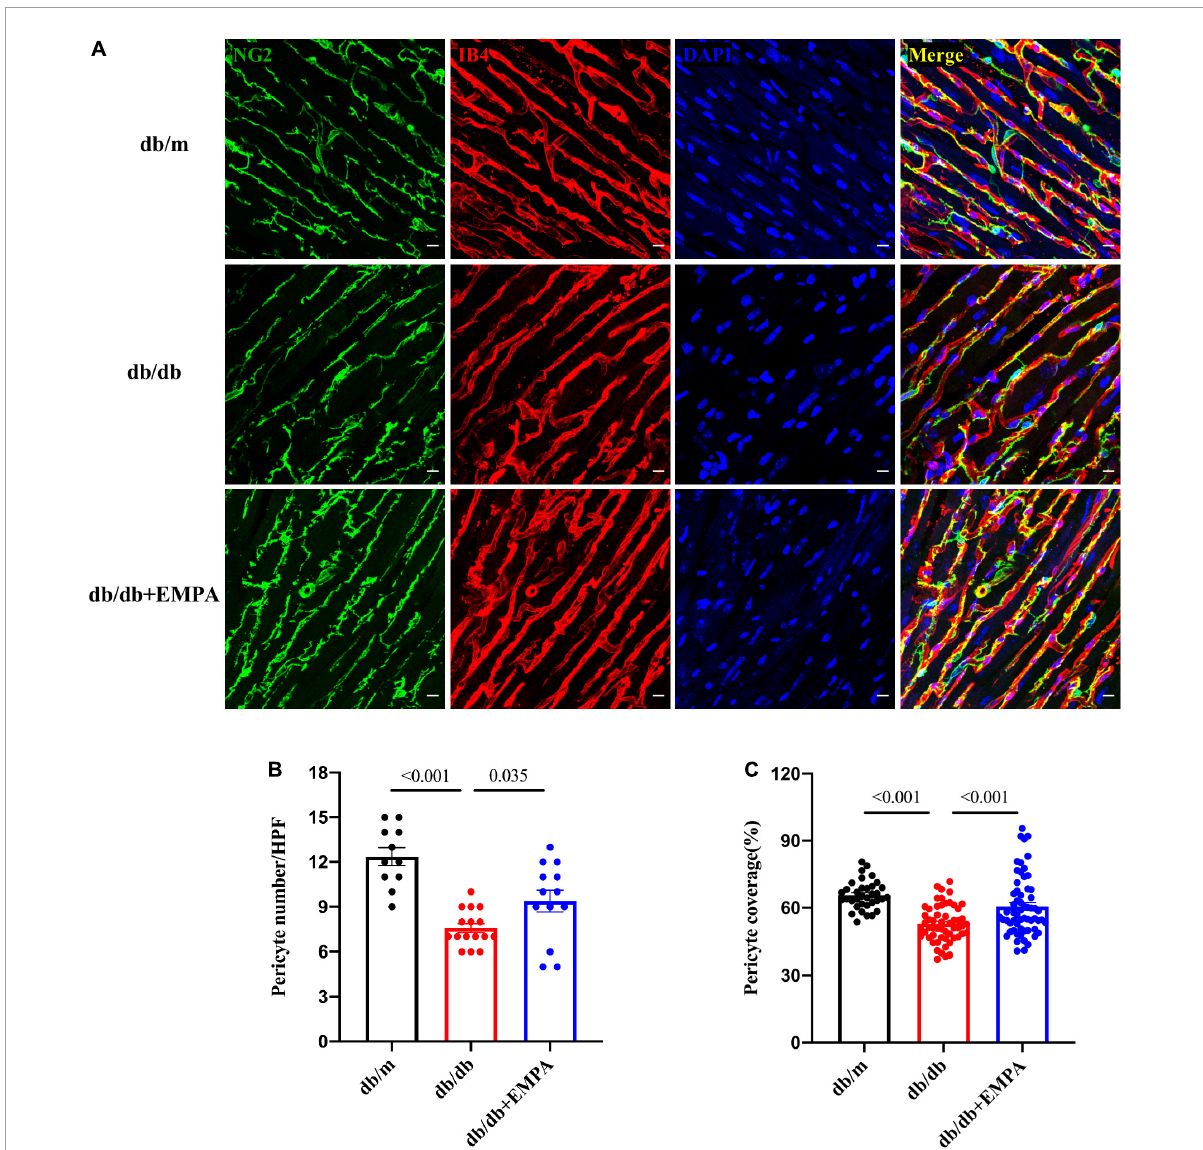
FIGURE5 Effects of empagliflozin treatment on pericytes in the hearts of db/db mice. (A) Representative myocardial sections showing pericytes (NG2+, green), capillaries (IB4+, red) and nuclei (DAPI+, blue). (B) Statistical analysis of pericyte number/HPF between the three groups. (C) Statistical analysis of pericyte coverage between the three groups, pericyte coverage = (NG2 + area/IB4 + area)/HPF*100%. Data are presented as the means ± SEM. P -values are corrected for multiple comparisons. NG2, neuroglial cell 2 chondroitin sulfate proteoglycan; IB4, isolectin B4; DAPI, 4 (cid:48) ,6-diamidino-2-phenylindole; HPF, high power